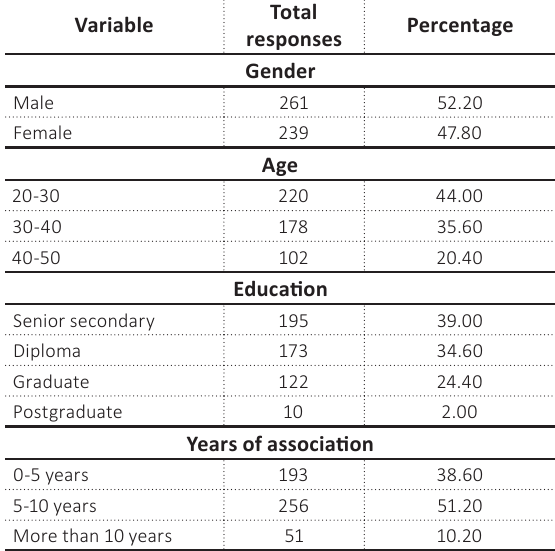
Table 1. Demographics of